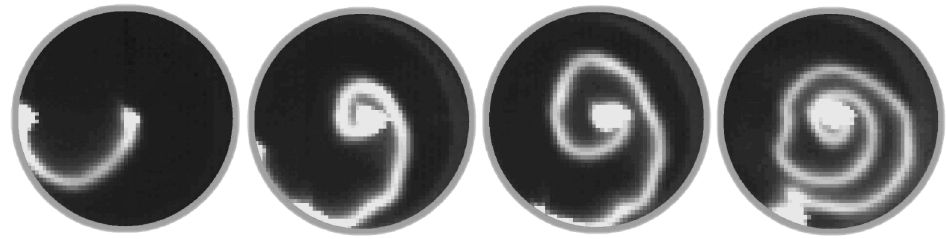
Figure 22. High speed imaging of interaction of electrical discharge with the external magnetic field of B = 0.05 T in air flow of 10 m/s (frame rate is 1.2 kHz); the external electrode is the cathode, current I = 1 A. Reprinted from [136] with permission from authors.